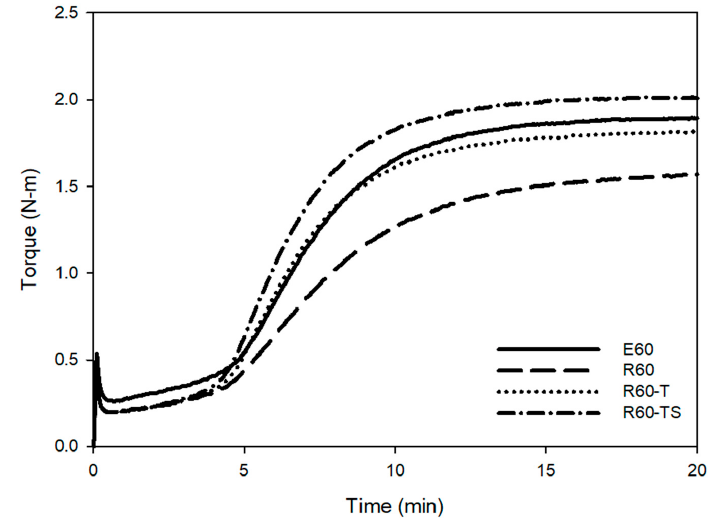
Figure 10. Cure characteristics of carbon black ‐ filled compounds with a controlled cure system.